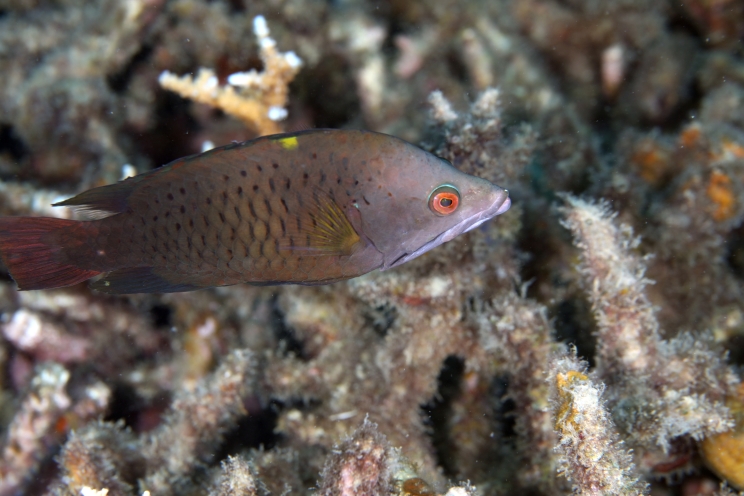
Epibulus
brevis (male)